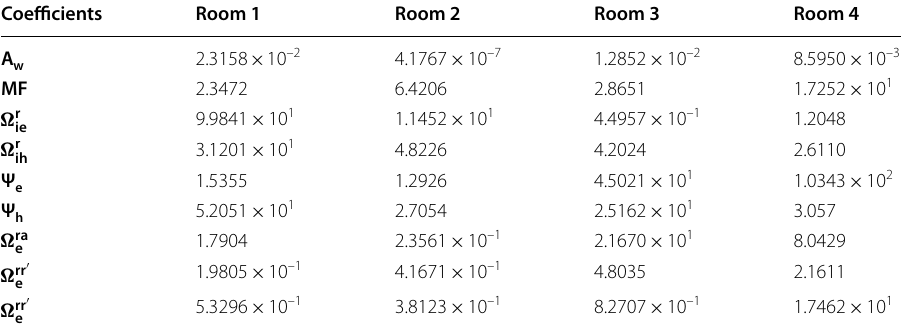
Table 4 Constant coefficients values for thermal dynamics of the understudy building extracted from CTSM-R (Golmohamadi et al. 2021) Coefficients Room 1 Room 2 Room 3 Room